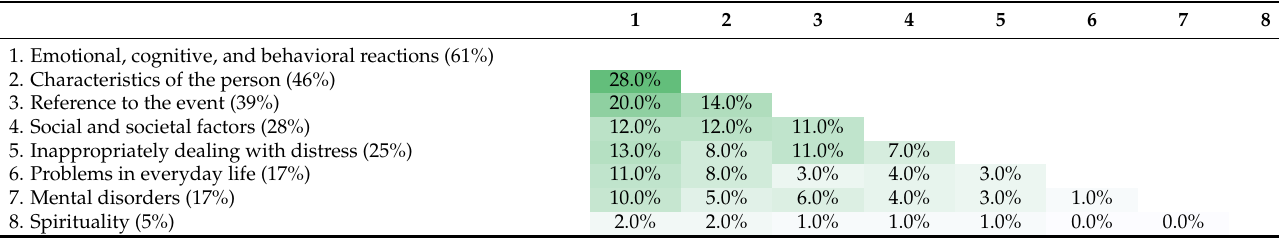
Table A1. Percentage of overlap between second-order themes.